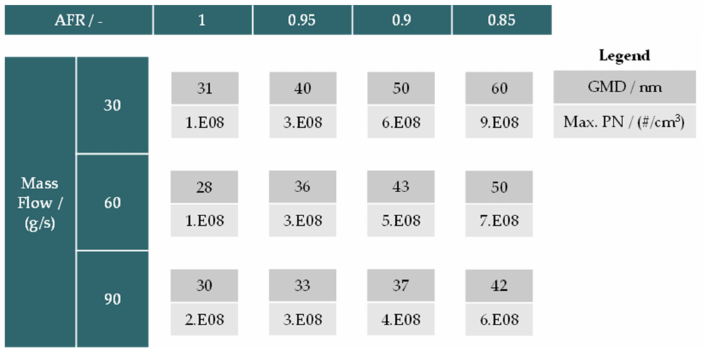
Figure 7. GMD and max. PN concentration values for exhaust gas mass flow rate and AFR variations at T exh = 600 ◦ C, obtained on the burner test bench.